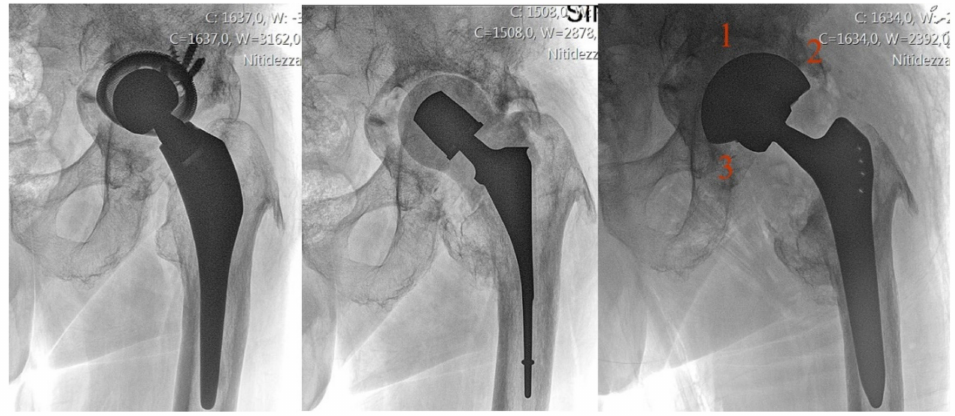
Figure 1. Three-point contact support for the cup: Point 1 antero-superior; point 2 postero-superior; point 3 postero-inferior. Points 1 and 2 are provided by the ilium and point 3 by the ischium. A trial component is put in place to check the seating and to determine the amount of morselized bone needed to fill the defects and the sections to be filled. One or more fresh-frozen (within 24 h of harvesting), non-irradiated, allogenous femoral heads are used as graft. The bone is morselized manually with a bone nibbler (Figure 2).